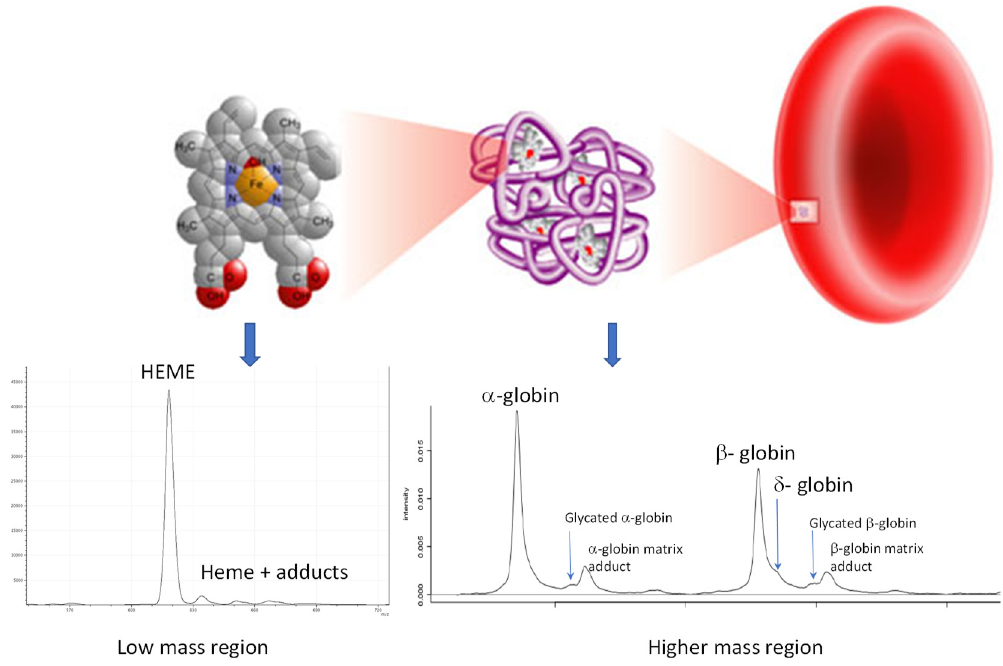
Figure 2. Illustration of lysis of red blood cells by adding whole blood to distilled water, resulting in hemoglobin release, which dissociates into free alpha and beta globin protein chains, along with free heme. These are then resolved simply by matrix-assisted laser desorption ionization time-of-flight (MALDI-ToF) mass spectrometry, thus allowing for the relative quantification of variants and adducts for clinical diagnostic purposes.